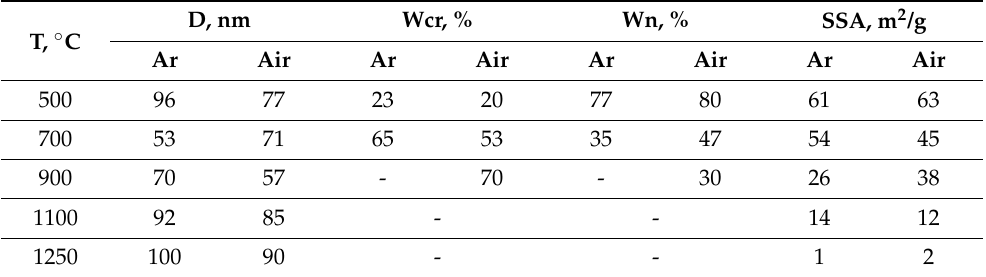
Table 2. Crystallite sizes of crystalline C12A7 (D), fractions of crystalline (Wcr) and nanocrystalline (Wn) C12A7, and SSA for samples obtained in Ar and air at different